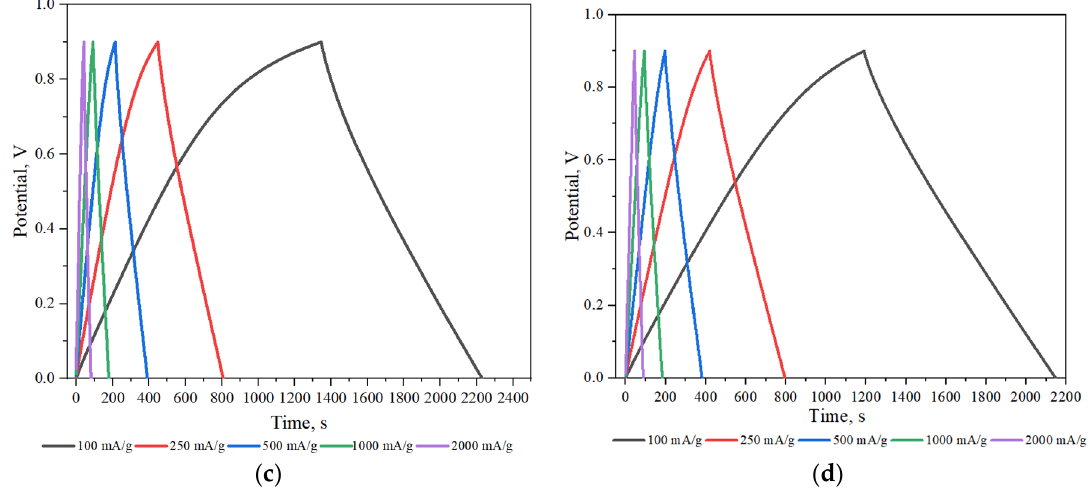
Figure 4. GCD curves at different charge–discharge current densities for ( a ) WS-dAC; ( b ) WS-